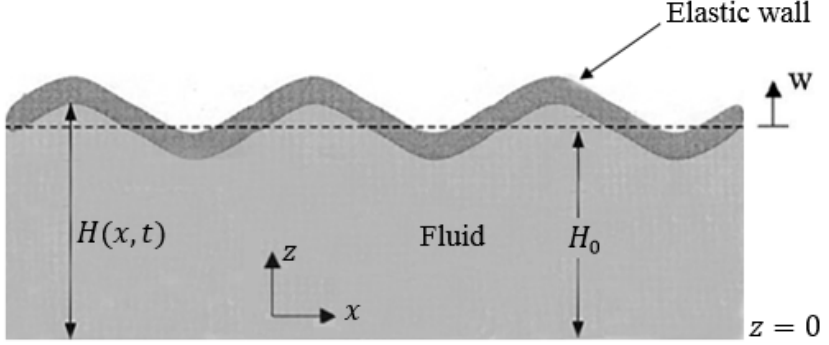
Figure 1. Fluid flow between elastic walls (half of the channel is